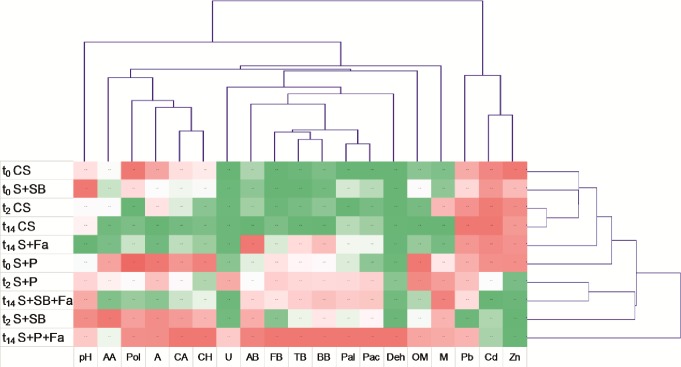
Cluster display of physicochemical and biological parameters of the control, untreated and treated soils at t0, t2 and t14 (mean±SD; n = 3).Legend: Zn–bioavailable fraction of Zn; Pb–bioavailable fraction of Pb; Cd–bioavailable fraction of Cd; M–moisture; OM–organic matter; Deh–dehydrogenase activity; Pac–acid phosphatase activity; Pal–alkaline phosphatase activity; U–urease activity; AA–amines/amides; Pol–polymers; A–amino acids; CA–carboxylic acids; CH–carbohydrates; BB–bacterial biomass; BA–actinomycetes biomass; FB–fungal biomass; TB–total biomass.